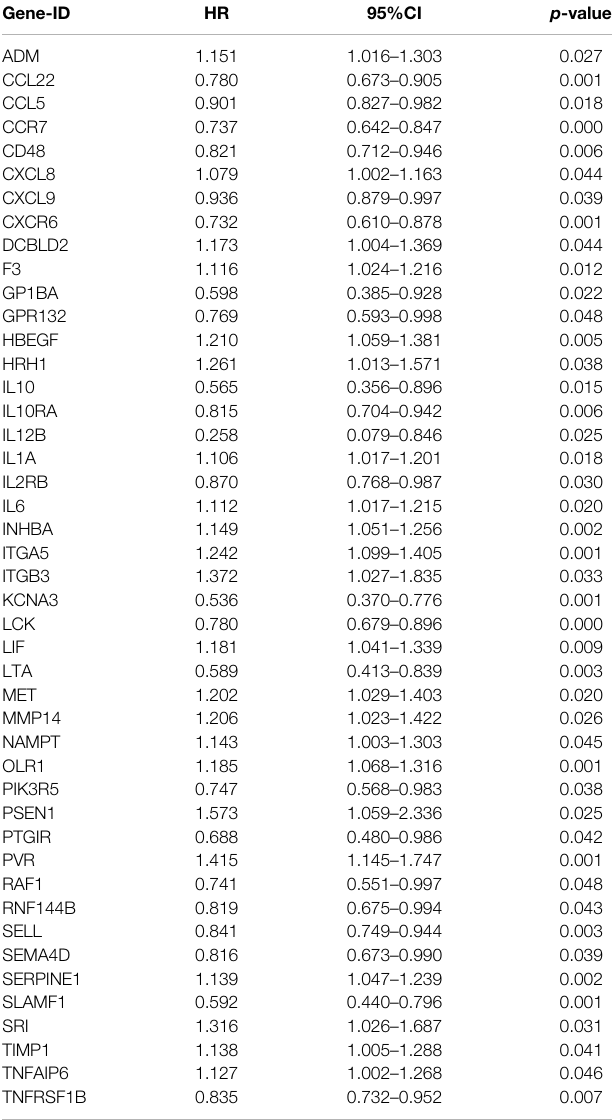
TABLE 1 | The results of the association between 45 in fl ammatory response – related genes expression and OS from univariate cox regression